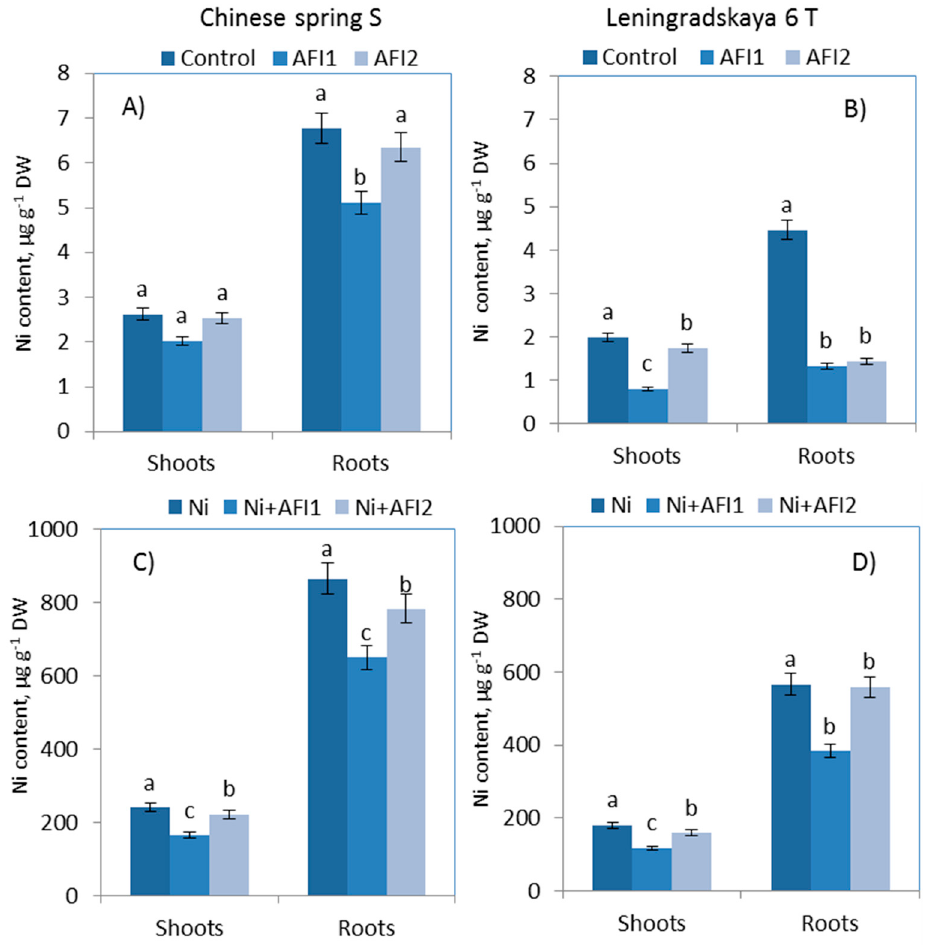
Figure 3. Ni content in shoots and roots of wheats: ( A , C ) Chinese spring S; ( B , D ) Leningradskaya 6 T. Different letters indicate a significant difference between the means at the probability level of p < 0.05, as determined by Duncan’s multiple range